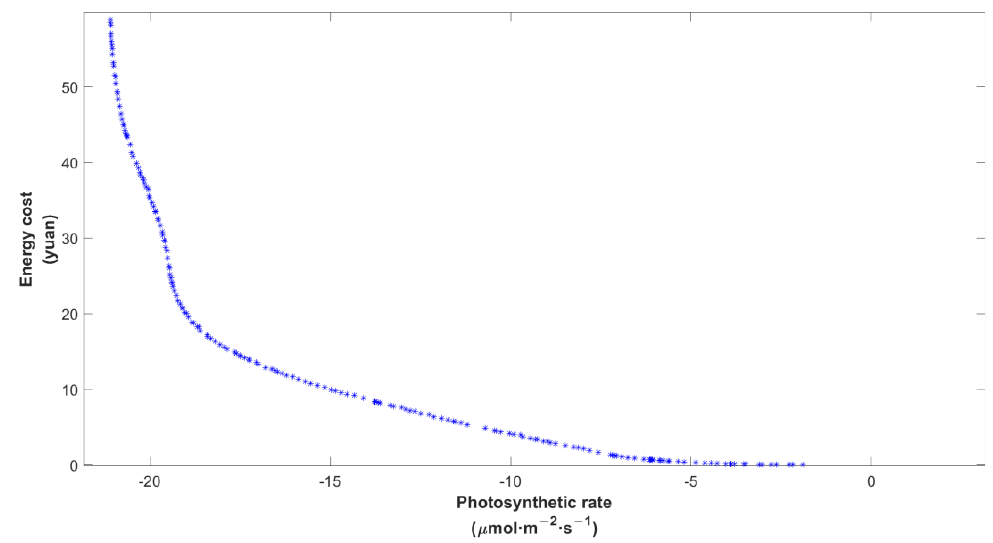
Figure 7. Pareto Frontier after multi-objective optimization at 28 °C. Each blue individual dot represented an optimal solution in the current state, and the blue curve formed was the Pareto Frontier of this operation.